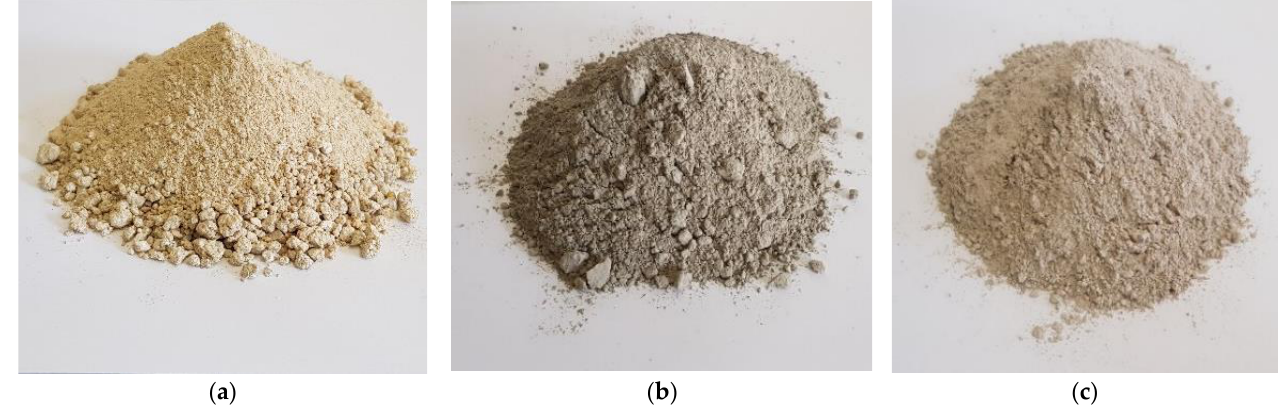
Figure 2. Raw materials used to produce the iCEBs: ( a ) soil; ( b ) cement; and ( c ) hydraulic lime. The soil was collected from the suburbs of the municipality of Vila Real, Portugal.